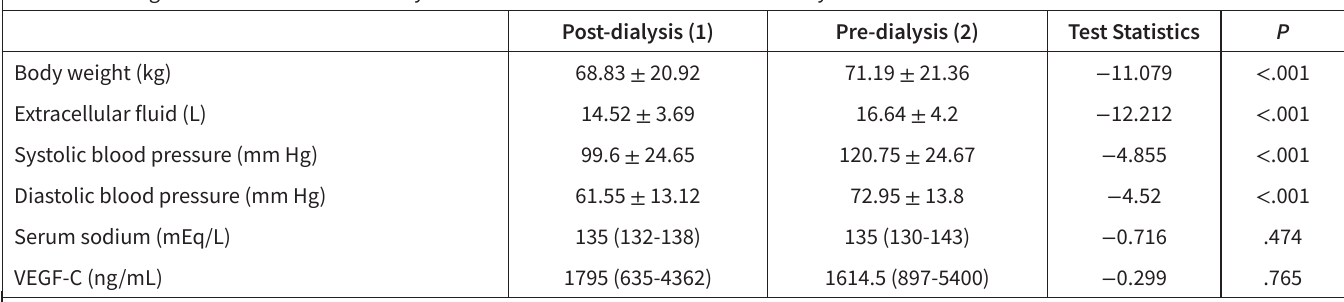
Table 2. Changes in Clinical and Laboratory Parameters of the Patients in the Interdialytic